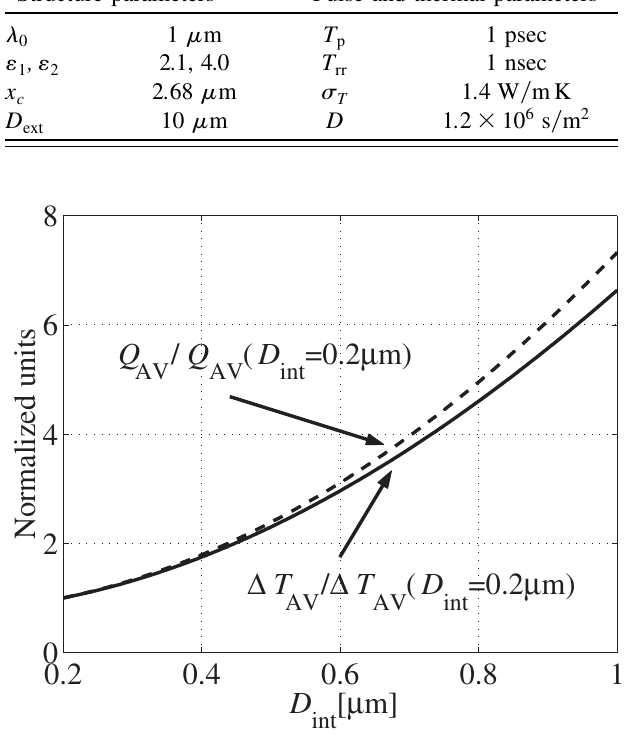
FIG. 2. The average change in temperature (cid:1) T average heat flow Q structure with the parameters given in Table I. Both quantities are normalized by their value at D 0 : 2 (cid:3) m (cid:4) (cid:6) 1 : 94 (cid:10) 10 8 tan (cid:1) [K] and Q